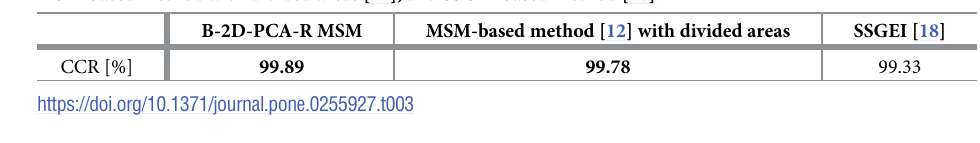
Gait recognition with the OU-ISIR Treadmill Dataset A. The OU-ISIR Treadmill Data- set A consists of gait images of 34 people, each with a gallery dataset and a probe dataset. From the dataset specification, 25 subjects are assigned for evaluation while the rest are used for parameter training, where the image resolution is 128 × 88. This dataset consists of gait images with speed variations (from 2 km/h to 10 km/h, every 1 km/h) for each gallery and probe data- set. Subjects walked for speeds between 2 km/h to 7 km/h and run for speeds between 8 km/h to 10 km/h. In our experiments, we used images with speeds between 2 km/h to 7 km/h, and we performed experimental evaluations with all combinations of gallery and probe speeds, i.e. 36 combinations (“6 different speed for each gallery dataset” × “6 different speeds for each probe dataset”). Table 3 lists the average classification rates of our B-2D-PCA-R MSM (99.89%), the MSM- based method with divided areas [12] (99.78%), and the SSGEI-based method [18] (99.33%). In Table 4, bold numbers and numbers in round brackets show results of cross-speed walking people identification with our B-2D-PCA-R MSM and the MSM-based method with divided areas [12], respectively. Our method shows slightly better performance than the MSM-based method [12]. Furthermore, the equal error rate (EER) by the proposed method is greatly improved compared with the MSM-based method with divided areas [12]. In the case that the absolute speed difference between the gallery and probe data is less than 2 [km/h], average EER is 0 for both the B-2D-PCA-R MSM and the MSM-based method with divided areas [12], as shown in Table 5. In the case that the absolute speed difference is greater than or equal to 2 Table 3. Comparison of average correct classification rate (CCR) [%] of each the proposed B-2D-PCA-R MSM, MSM-based method with divided areas [12], and SSGEI-based method [18].